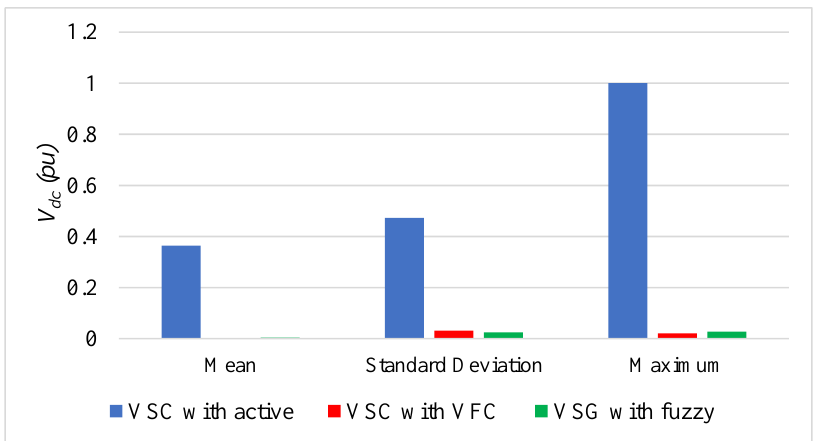
Figure 40. DC-link voltage statistics of DER 1 for the different scenarios presented in Section